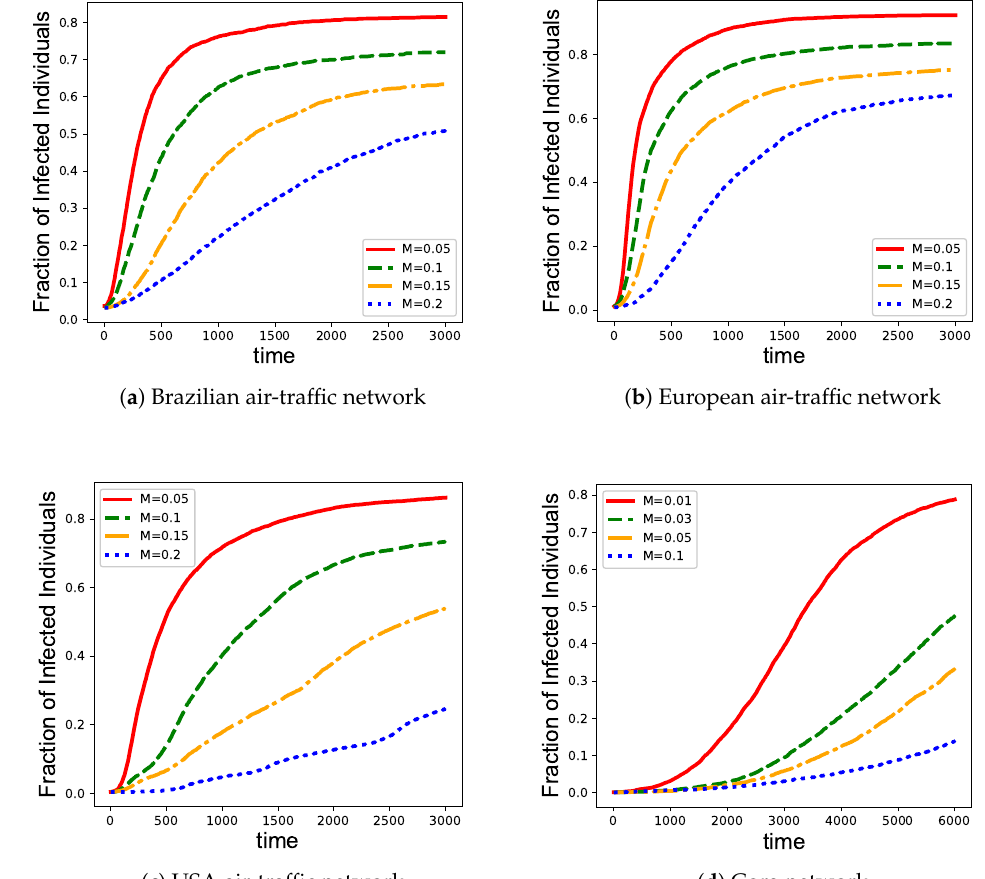
Figure 4. Performance comparison among different immunization strategies on four benchmark networks given different vaccinate coverage. ( a ) Brazilian air-traffic network; ( b ) European air-traffic network; ( c ) USA air-traffic network; and ( d ) Cora network. The x axis represents the infection time of the nodes. The y axis represents the fraction of infected nodes in the network.